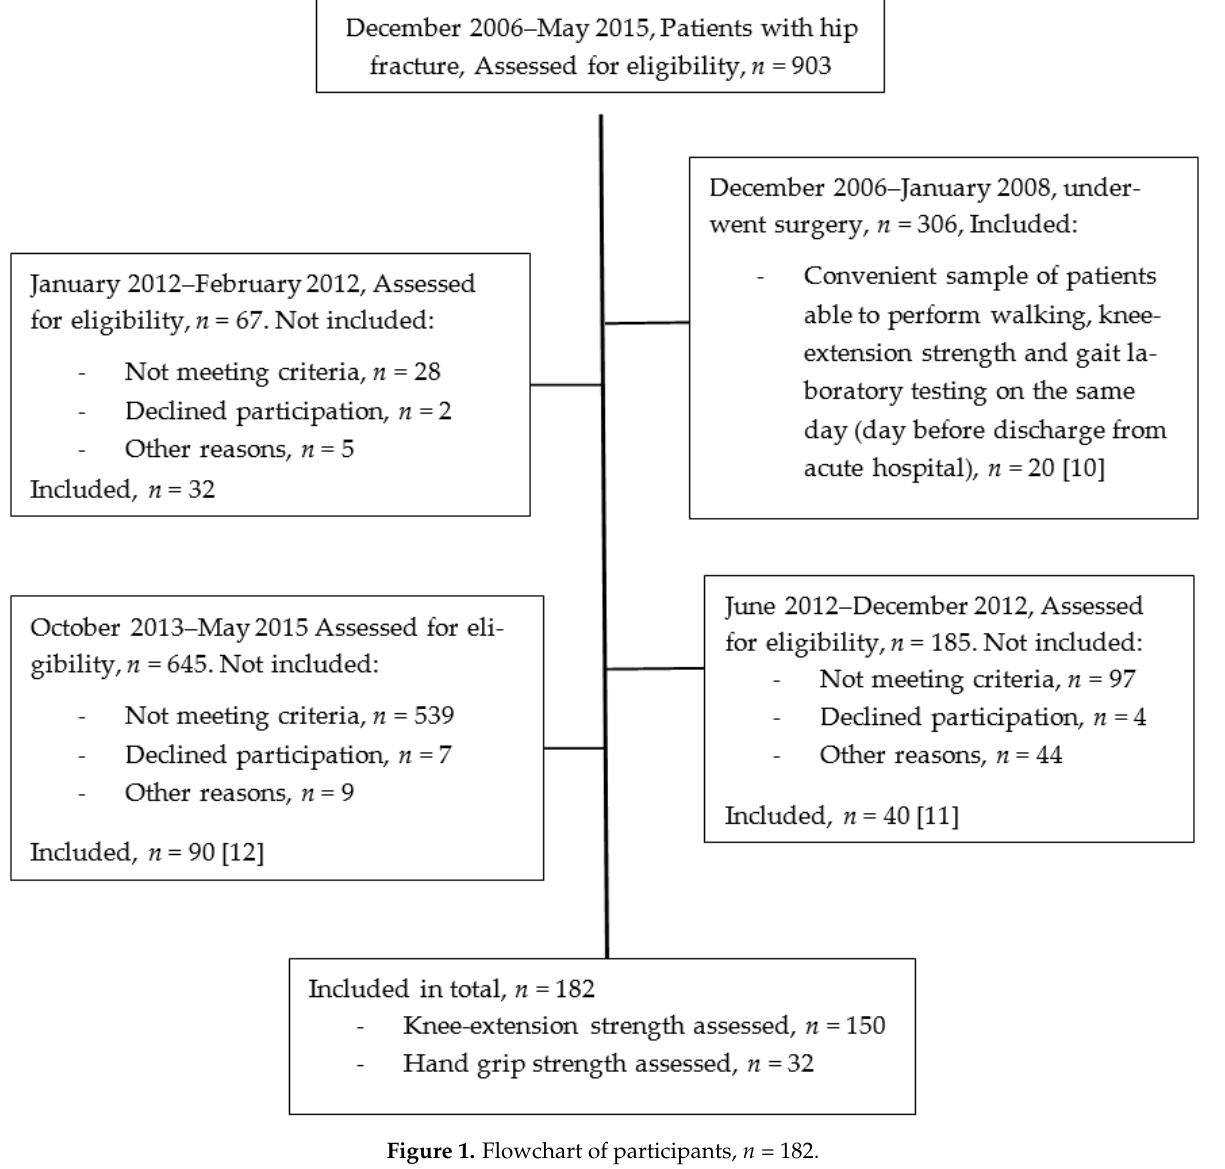
Figure 1. Flowchart of participants, n = 182.